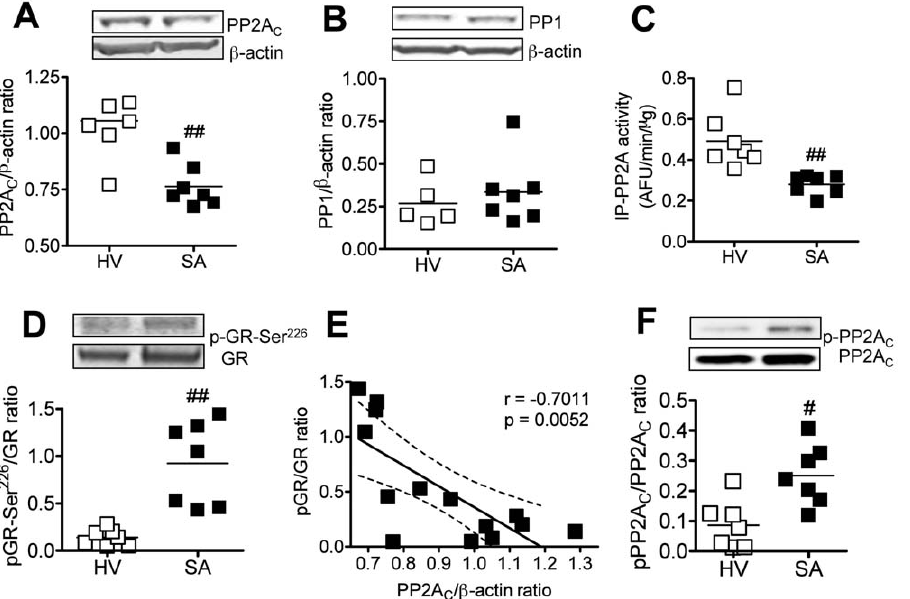
Figure 3. PP2Ac expression and activity in severe asthma. PP2A C protein expression (A), PP1 protein expression (B), immunoprecipitated PP2A (IP-PP2A) activity (C), phosophorylation levels of GR-Ser 226 (D) and PP2A C -Tyr 307 (F) in PBMCs from severe asthmatics (SA) and healthy volunteers (HV). E. Correlation between PP2A C expression and GR-Ser 226 phosphorylation. The dotted lines show 95% confidence interval. # P , 0.05, ## P , 0.01 (vs.